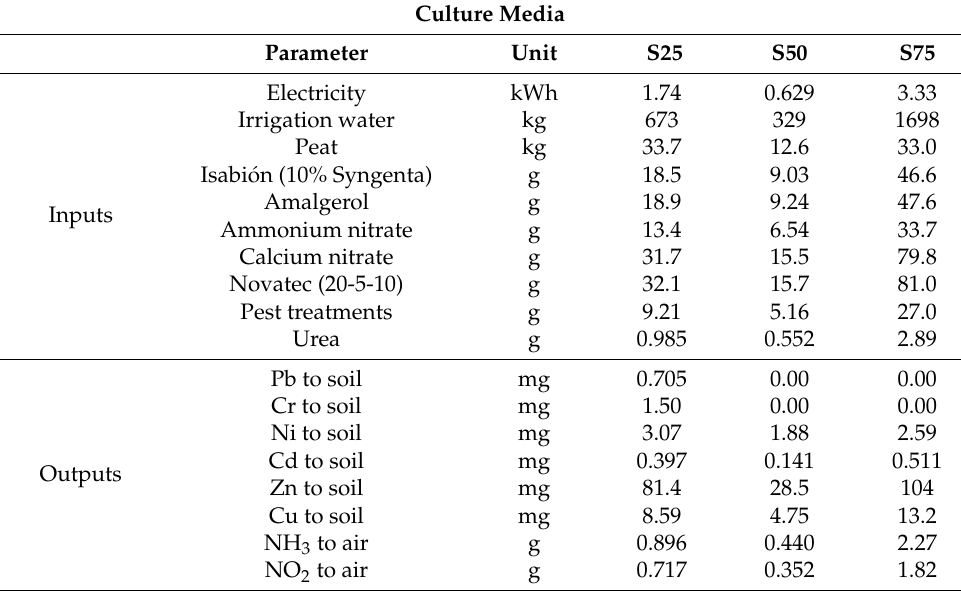
Table 4. Input and output inventory for the production of 1 kg of ‘Verna‘ lemons, cultivated on different culture media, based on a port sediment and peat